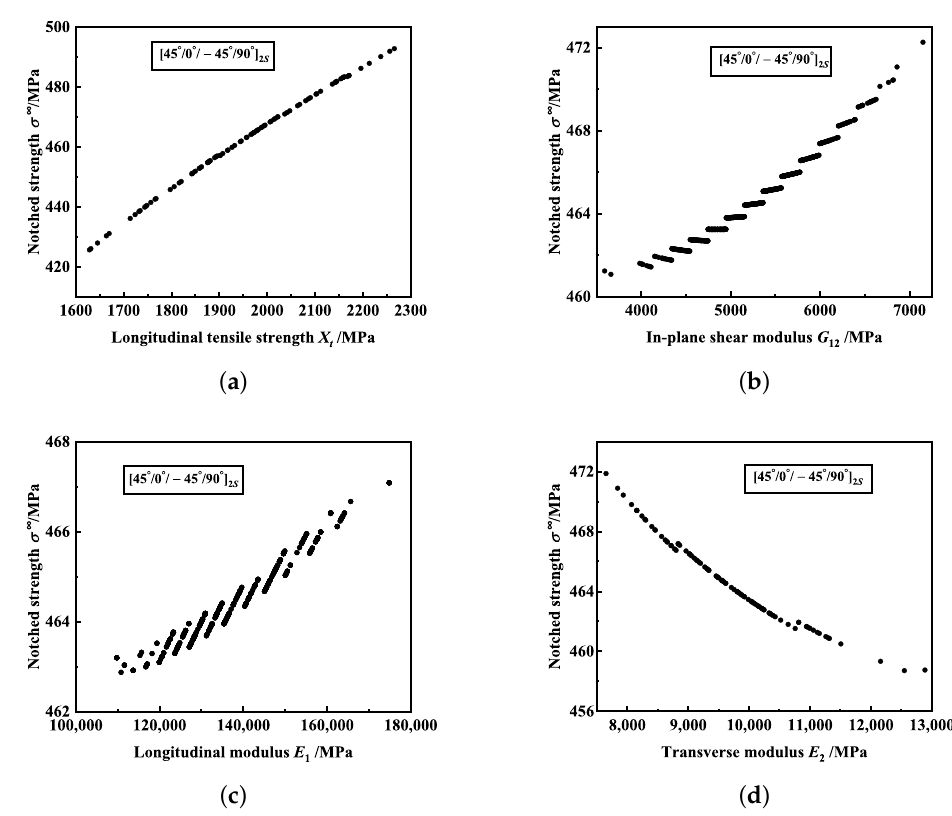
Figure 6. The influence of material properties on the tendency of failure strength for notched laminate with [ 45 ◦ /0 ◦ / − 45 ◦ /90 ◦ ] and 2 R = 3.81 mm: ( a ) Longitudinal tensile strength X t . ( b ) In-plane 2 s shear modulus G 12 . ( c ) Longitudinal modulus E 1 . ( d ) Transverse modulus E 2